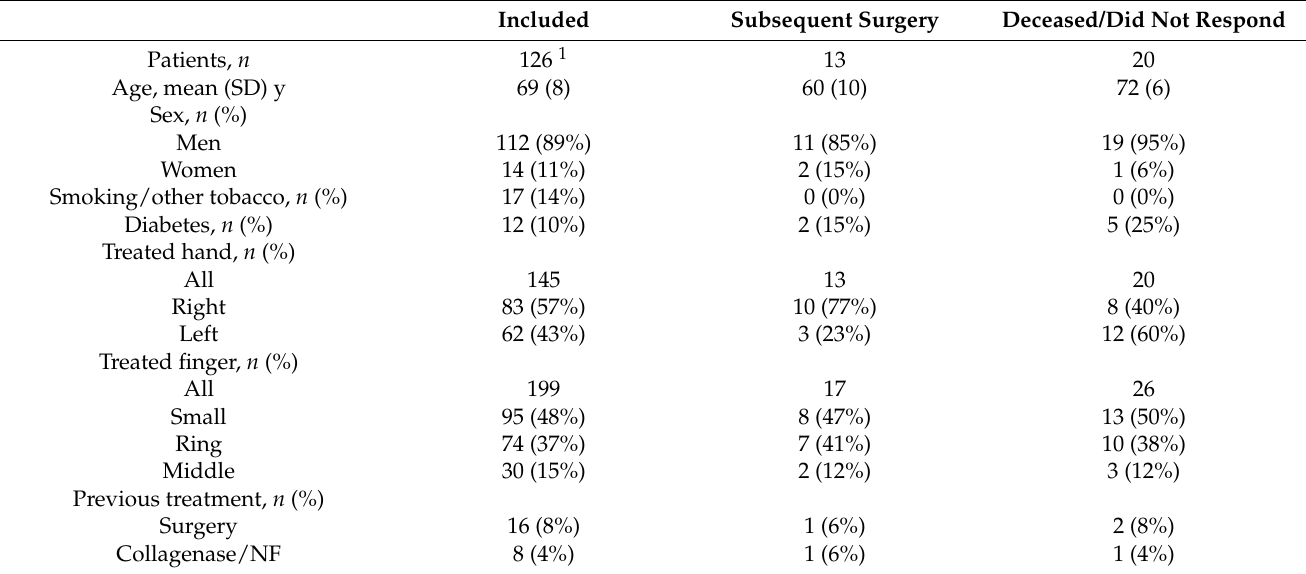
Table 1. Patient characteristics.